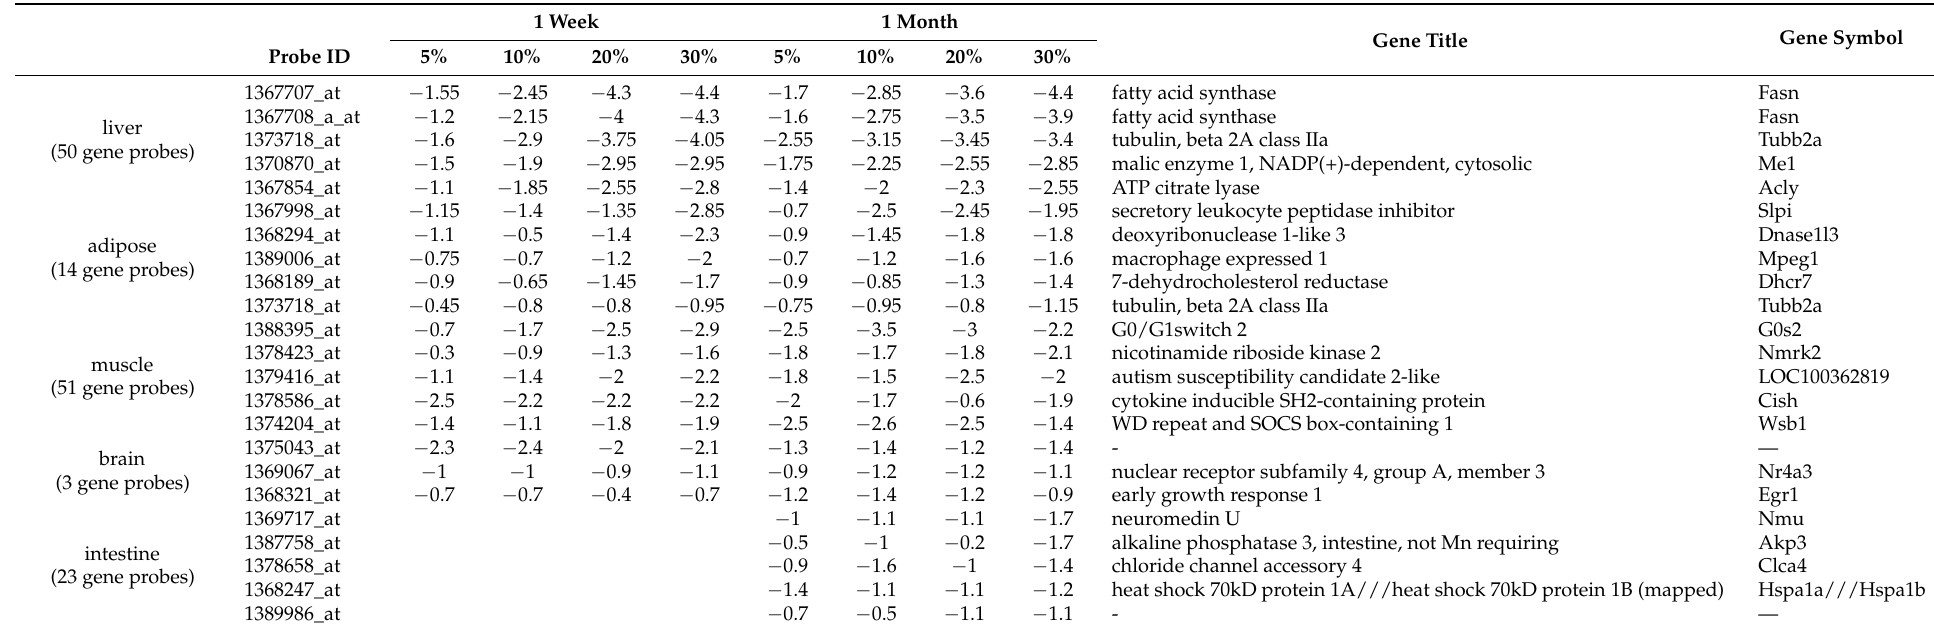
Table 3. Top five gene probes consistently down-regulate across all CR levels for each